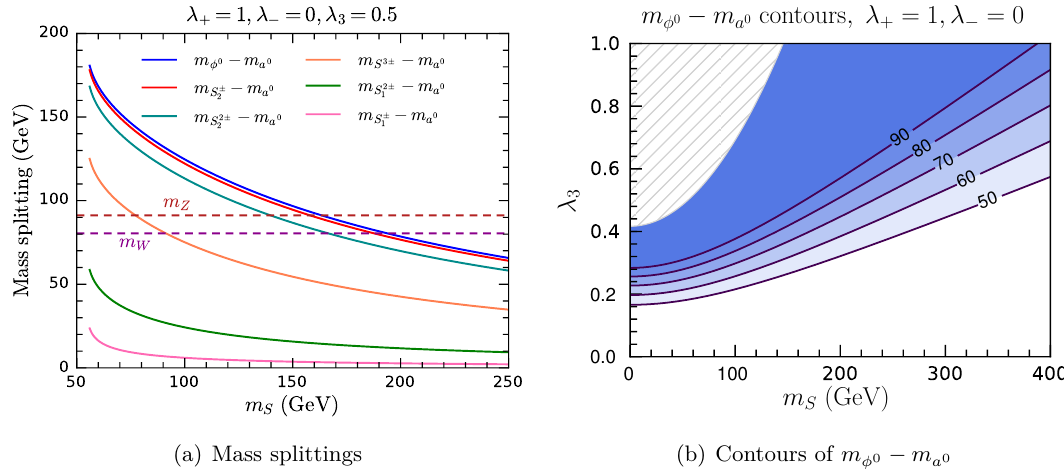
Figure 1 . Mass splittings among the dark sector scalars. (a) Mass splittings between a 0 and the other scalar bosons for λ + = 1 , λ − = 0 , and λ 3 = 0 . 5 . (b) Contours of the mass splitting in